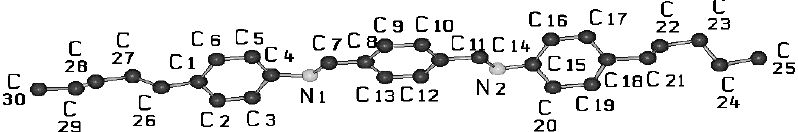
Figure 31. Conformation of crystalline TBAA-5(2) and atom numbering at ambient temperature.